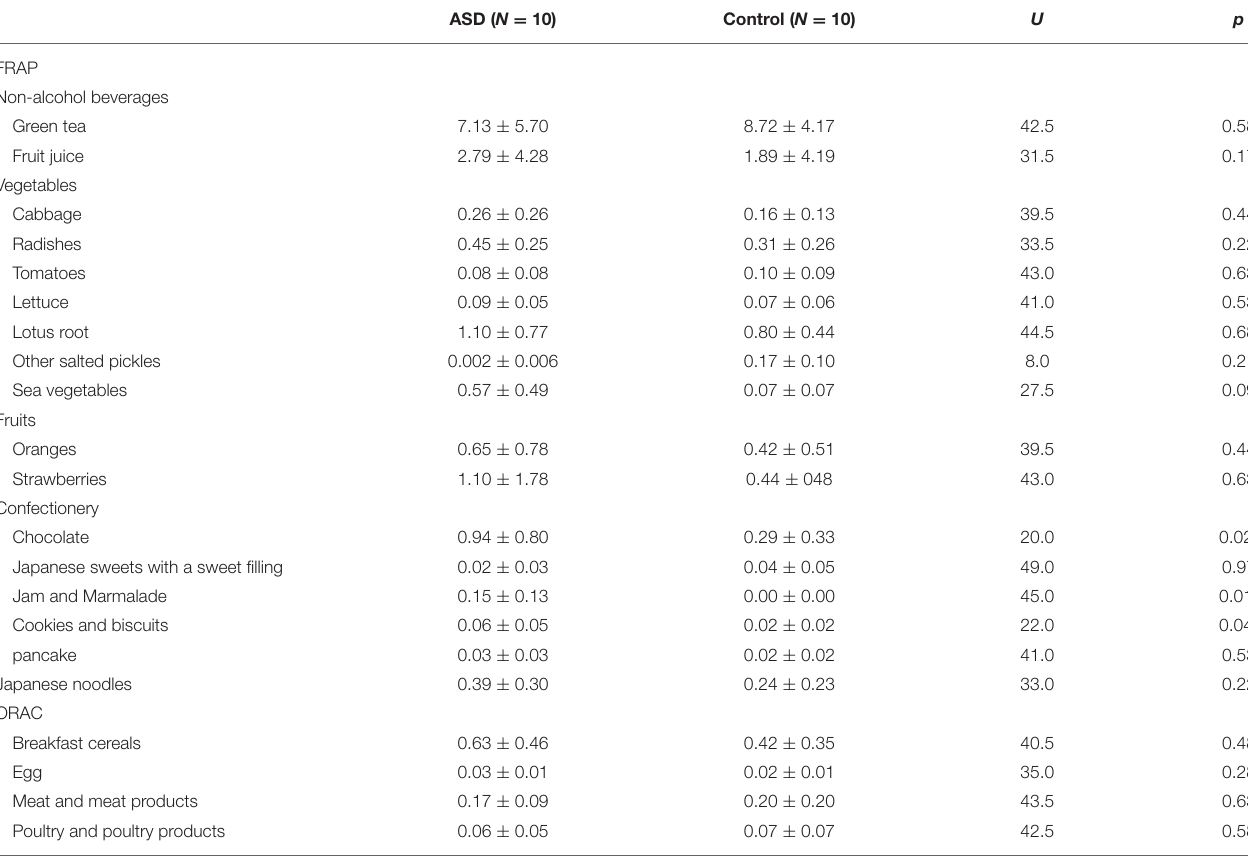
TABLE 3 | Dietary TAP in the random subsamples that include 10 individuals with 10 individuals with ASD and 10 normal controls. ASD ( N =